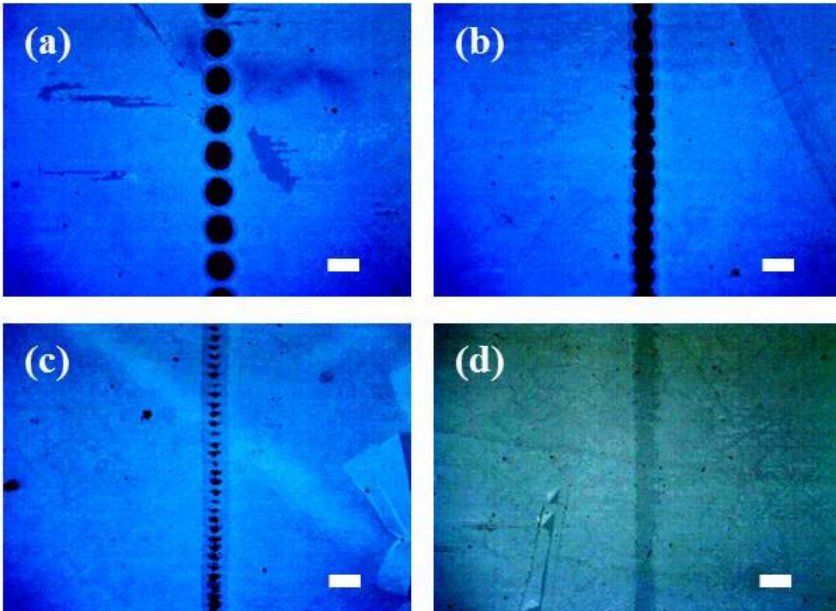
Figure 3. Optical microscopy images of the laser-patterned lines on the graphene/ITO double layer on a glass substrate produced with a scanning speed of 1000 mm/s at pulse energies of ( a ) 266.5, ( b ) 156.5, ( c ) 88.1, and ( d ) 44.6 μ J. White lines correspond to 100 μ m.